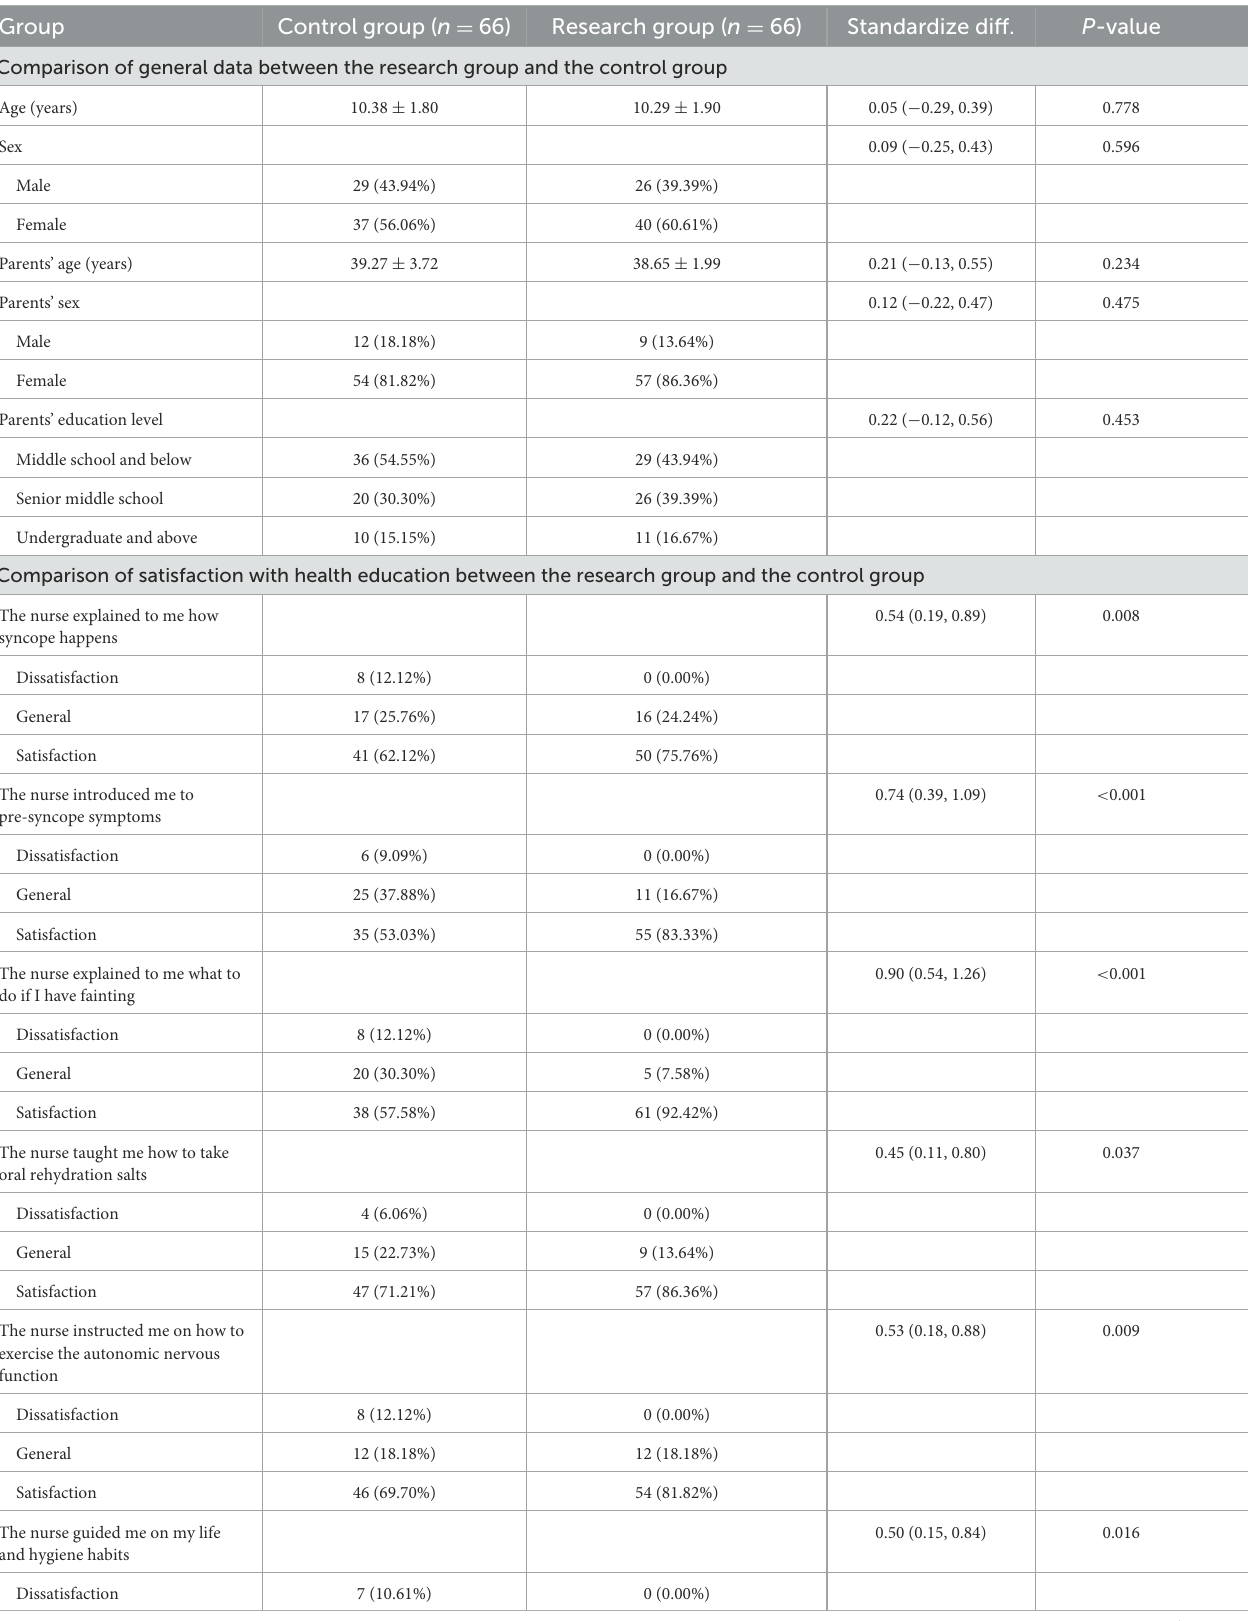
TABLE 1 General data of the study population and description of questionnaire data [Mean ± SD/ n (%)]. Group Control group ( n = 66) Research group ( n = 66) Standardize diff. P -value Comparison of general data between the research group and the control group Age